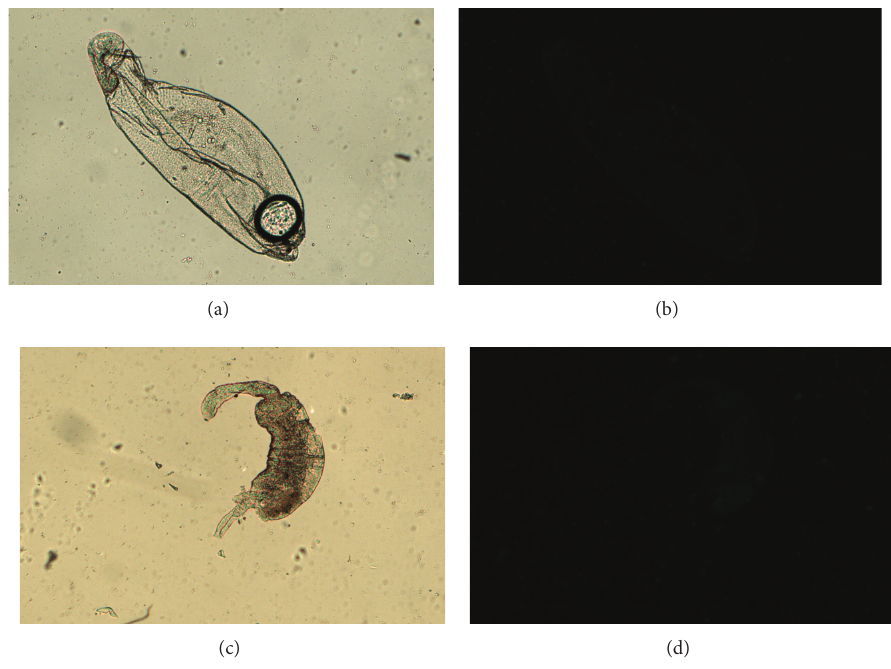
Figure 2: Bright field (a) and fluorescence (b) images of the FITC-CFL. The same images were acquired with the FITC-CFL blocked with D-mannose (c) and